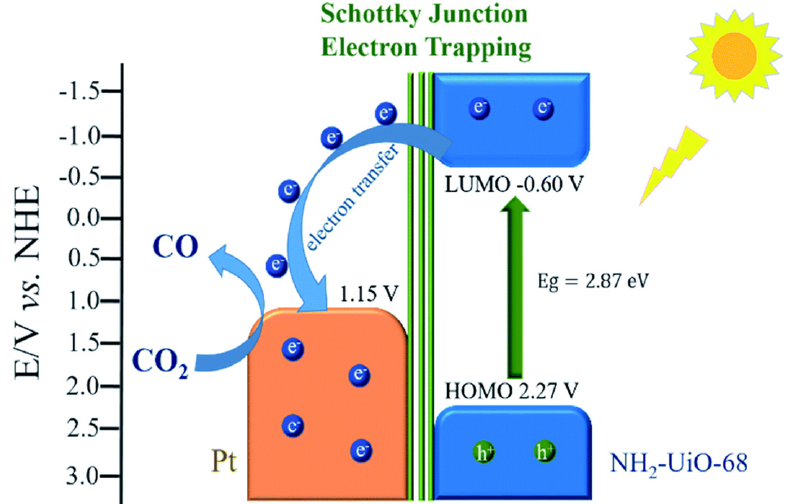
Figure 6. Schematic illustration showing the electron transfer process at the Pt and NH 2 -UiO-68 interface based on the energy levels. Reproduced with permission from [102]. Copyright 2019, the Royal Society of Chemistry.